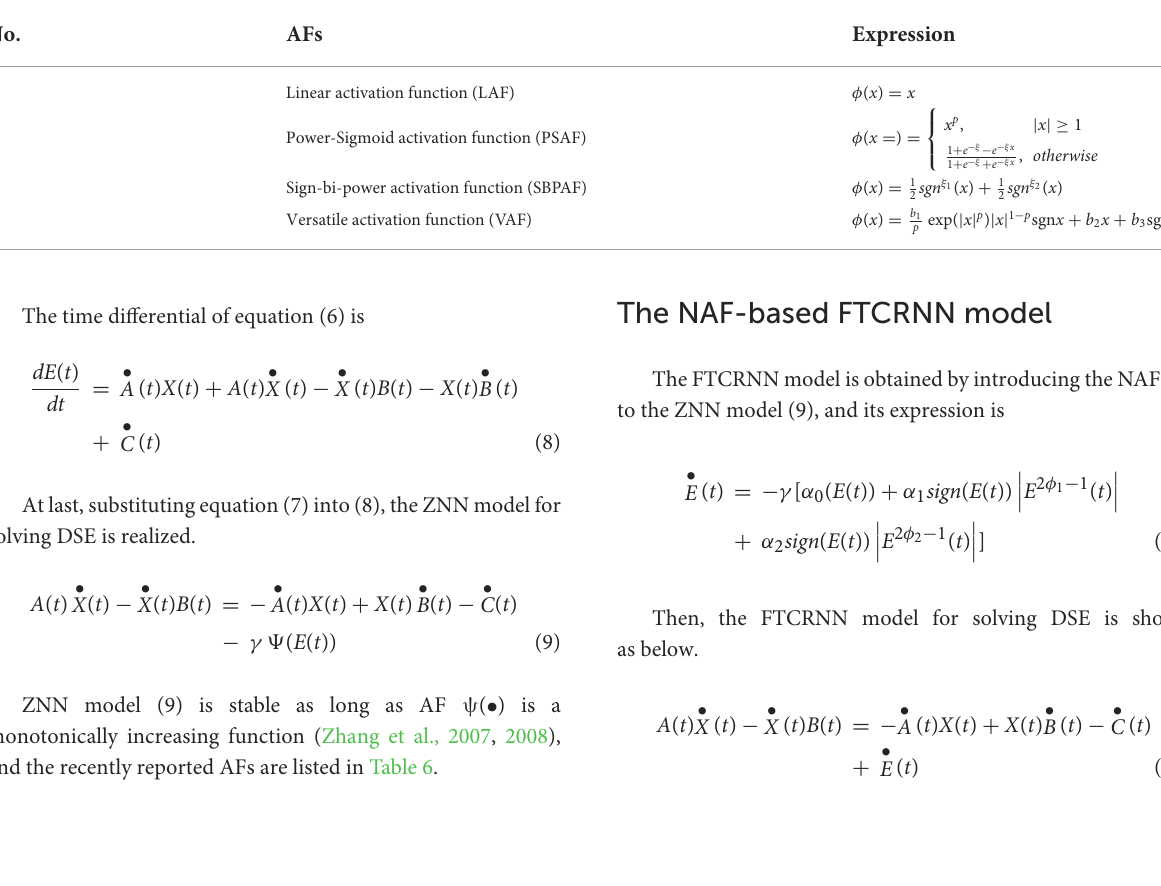
TABLE 6 Recently reported AFs for ZNN model